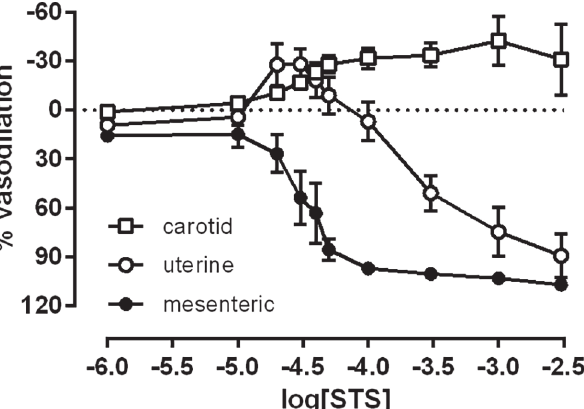
Fig 1. Direct vasodilator effects of STS in rat arteries. Vascular responses to STS in the carotid (open squares, n = 8), uterine (open circles, n = 10), and mesenteric arteries (closed circles, n = 8) from the pregnant rat (GD 10.9 ±